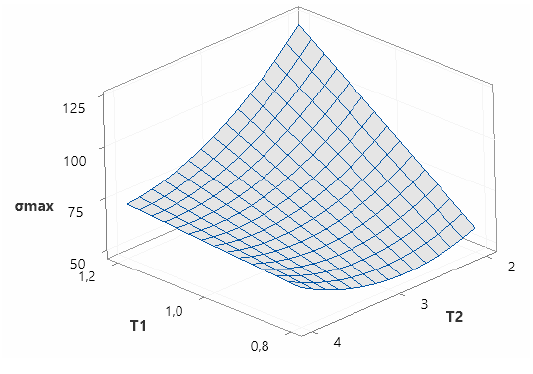
Figure 17. Surface plot of max ∈ and T 1; T 2 (for L = 11 mm)